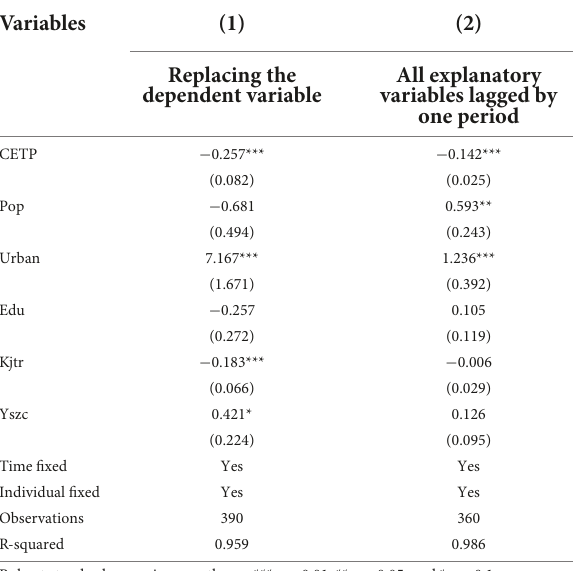
TABLE 8 Robustness check